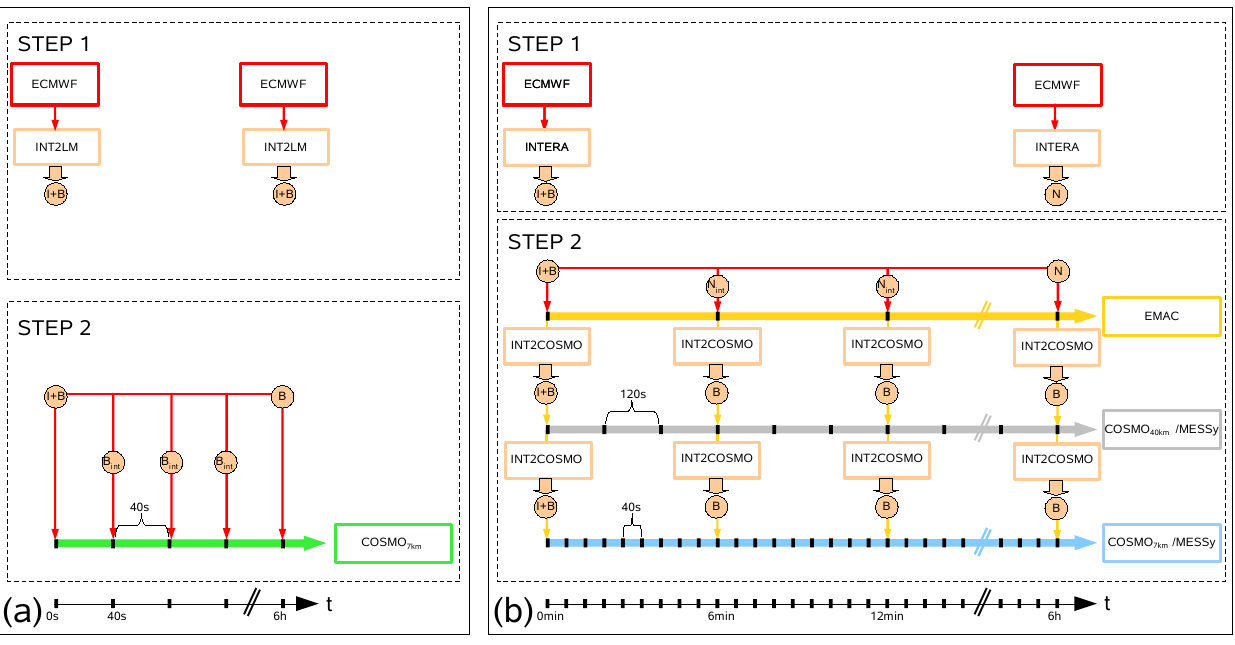
Fig. 1. Schematic illustration of the temporal evolution of (a) off-line and (b) on-line simulations. Abbreviations are used for boundary (B), initial (I), nudging (N) and interpolated (int) data.